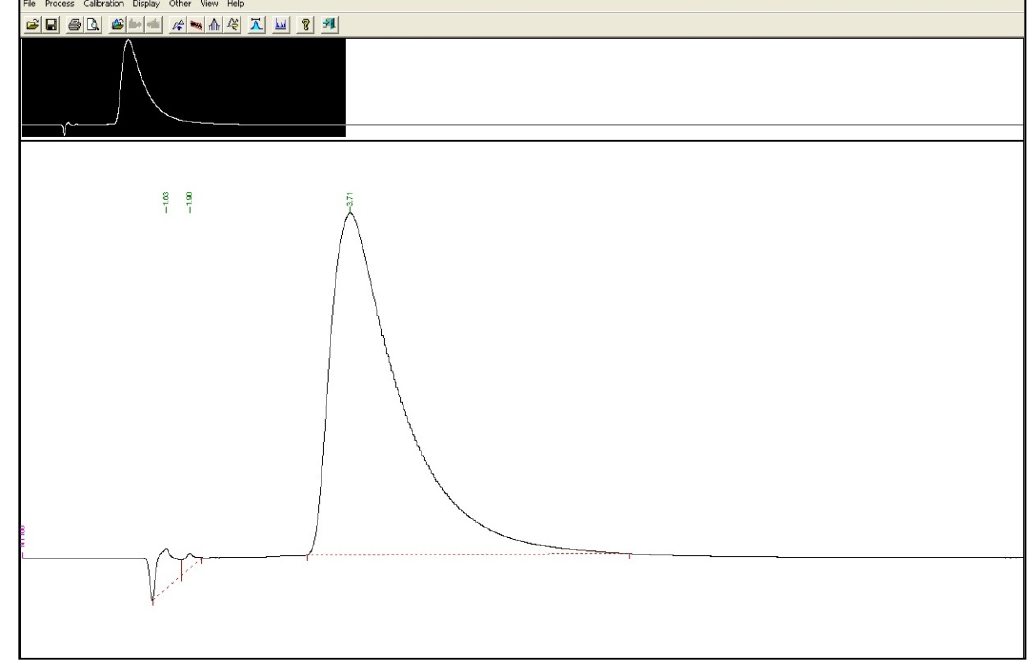
Figure A4. Example chromatogram obtained on an HPLC column with HSA immobilized on a stationary phase. In this case, rosuvastatin is presented. The void time marker is methanol (t = 1.63) used to dissolve the APIs’ samples, then the peak of rosuvastatin is visible (t = 3.71) .